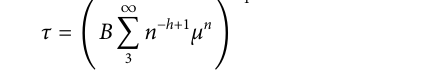
Frontiers in Physics |